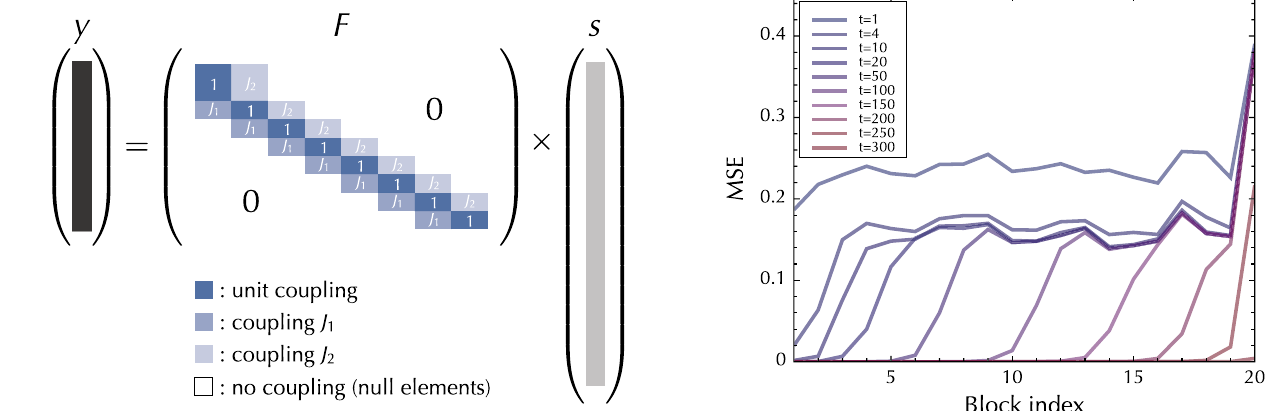
> 1 ¼ 0 : 4 and size 0 ¼ 20 , J ¼ 1 2